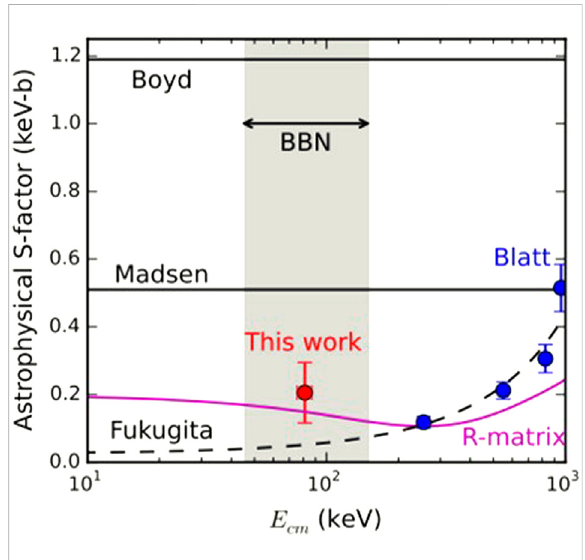
FIGURE 11 Comparison between OMEGA [9] and accelerator measurements [53 – 56] for the T( 3 He, γ ) 6 Li S factor. The OMEGA measurementistheonlyoftheseexperiments thatwasperformed at an energy directly relevant to BBN. The “ R-matrix ” line is a fi t performed to the data from Ref. 53 when corrected for angular effects [9]. The OMEGA measurement agrees with this fi t. Plot originally published in Ref. 9 and reproduced with permission